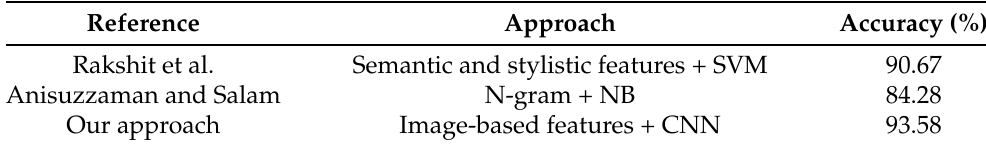
Table 12. The obtained accuracies of the existing systems on our